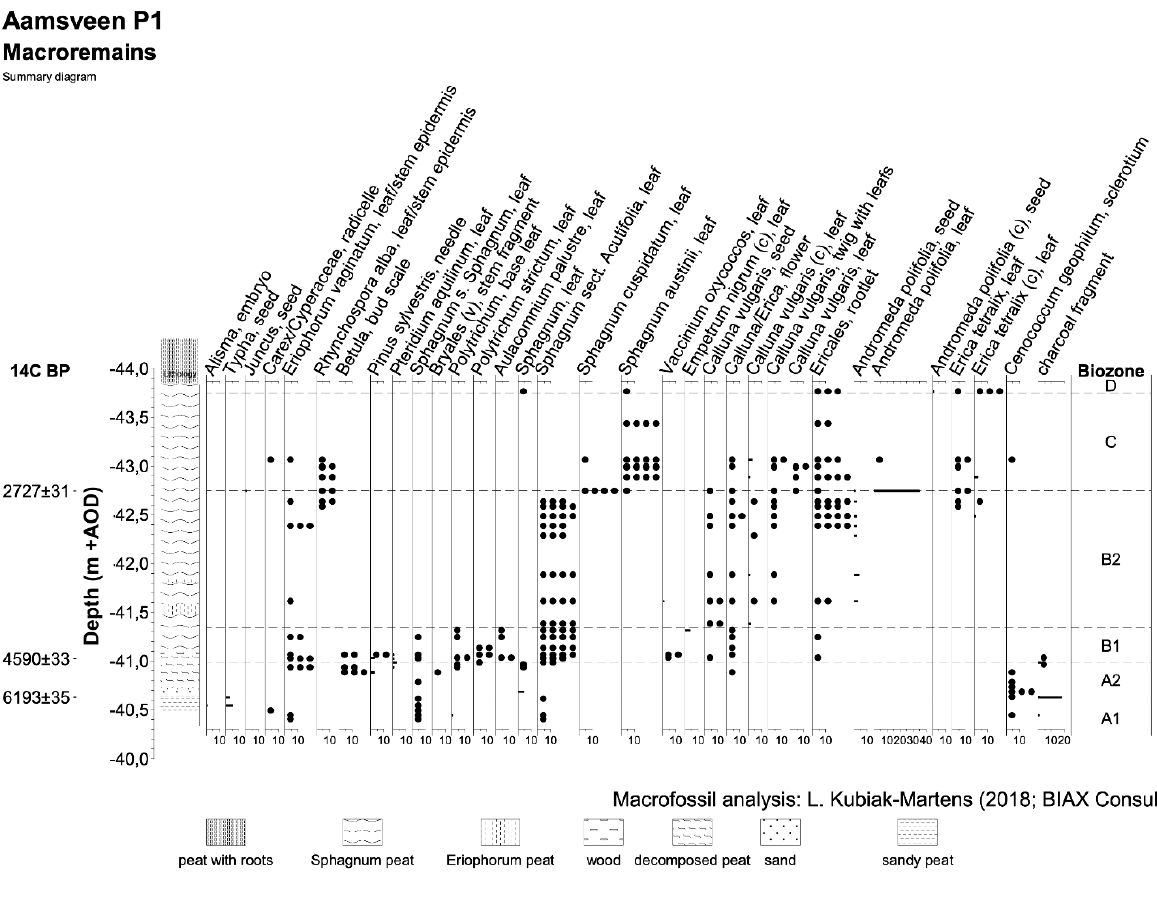
Figure 5. Simplified macrofossil diagram for Core